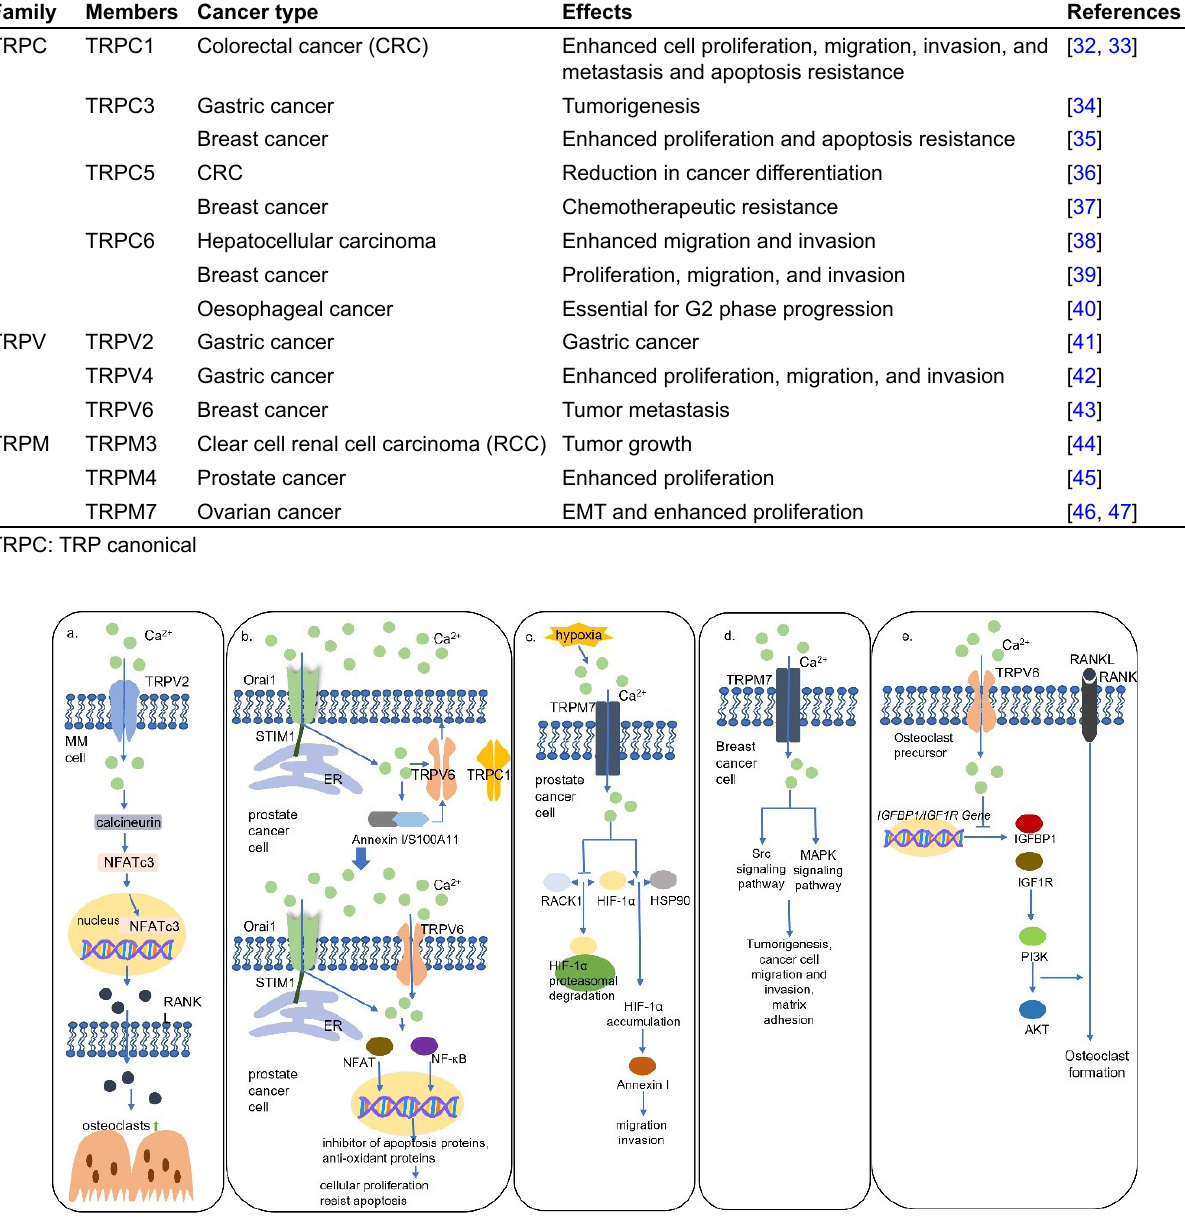
Figure 2. Schematic models for Ca 2+ channels mediated Ca 2+ signaling pathways. (a) TRPV2 mediates the secretion of RANKL via the Ca 2+ -calcineurin-NFATc3 signaling pathway in MM cells to activate osteoclast formation; (b) TRPV6 channels are translocated to the plasma membrane via the STIM1/Orai1 mediated Ca 2+ /Annexin I/S100A11 pathway. TRPV6 channels activate NFAT and nuclear factor κB (NF-κB) to promote proliferation, apoptosis resistance, and bone metastasis in prostate cancer cells; (c) hypoxia results in TRPM7-dependent hypoxia-inducible factor 1α (HIF-1α) accumulation which activates downstream Annexin I to promote cell migration and invasion in prostate cancer cells; (d) TRPM7 channels activate Src and mitogen-activated protein kinase (MAPK) signaling pathways to induce migration and invasion of breast cancer cells; (e) TRPV6 channels inhibit osteoclast formation by inhibiting the IGF/phosphatidylinositol 3-kinase (PI3K)/protein kinase B (AKT) signaling pathway. HSP90: heat shock protein